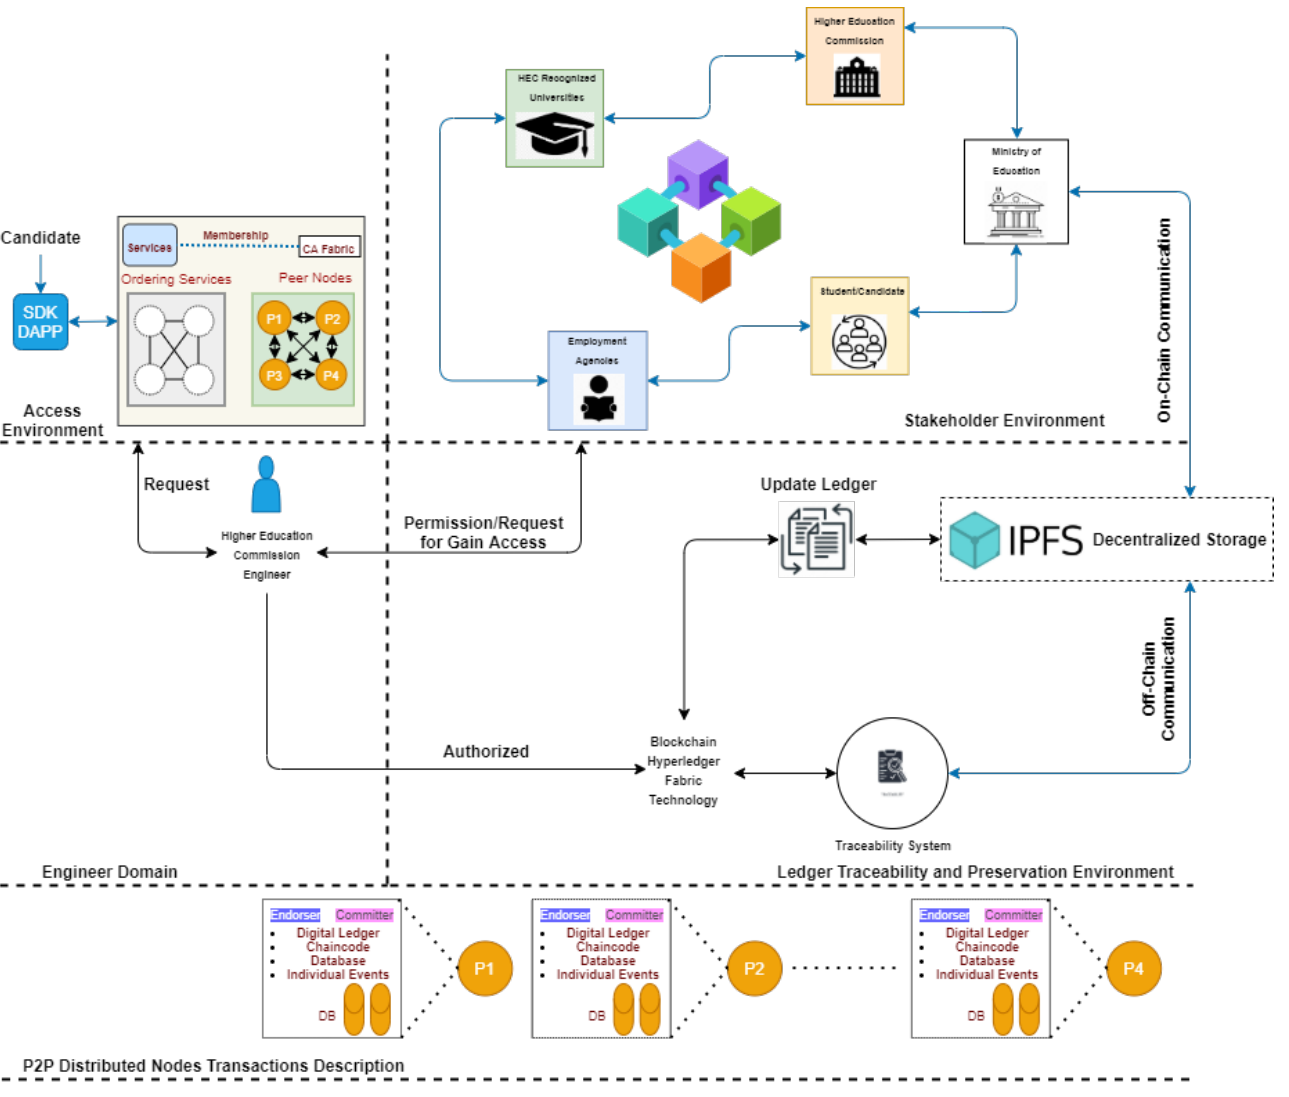
Figure 3. Proposed blockchain hyperledger fabric-enabled degree attestation verification and traceability architecture for HEC.